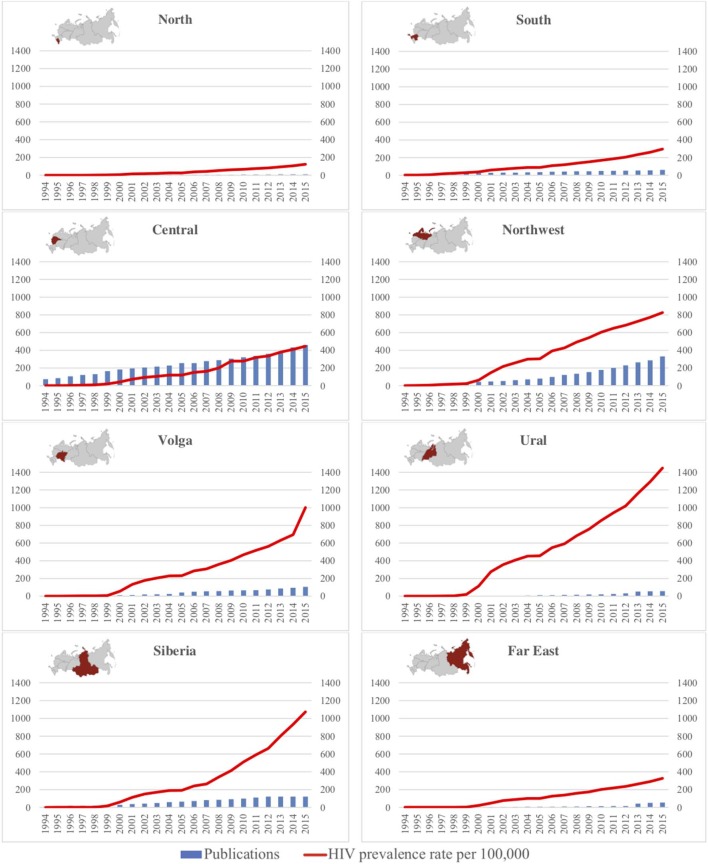
Temporal trends in publications and HIV prevalence per Russian federal district.